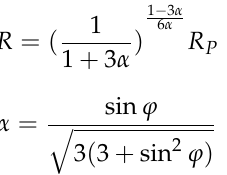
Figure 14. Error rates distribution of plastic zone under different methods, different GSI values, and different depths. As can be seen from Figure 14, the error of RE method is larger among the three methods. The smaller the GSI value is and the deeper the depth is, the larger the error is and the more uneven the error distribution between different depths is. The error of EQ method is the smallest among the three methods. With the decrease of GSI value, the po- sition error of deeper buried depth is gradually larger than that of shallower buried depth. The error of AN method is more uniform in depth, and the deeper the depth, the smaller the error.